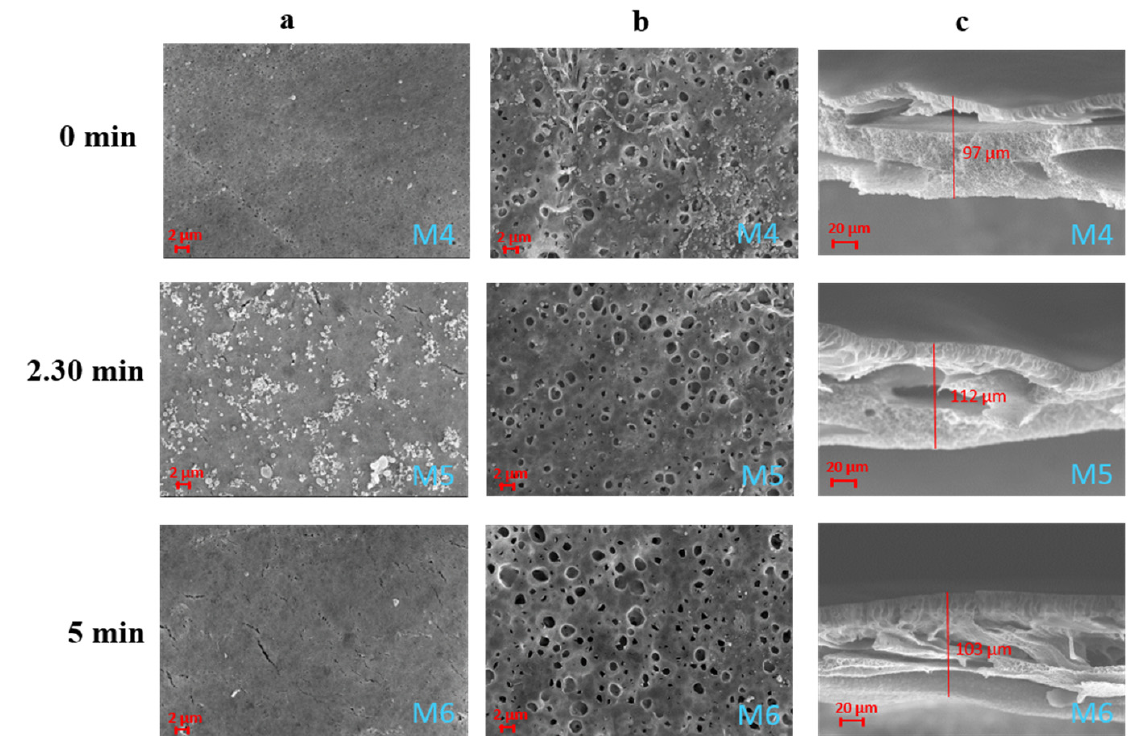
Figure 3. SEM images illustrating the effect of the exposure time to humidity on PVDF-HFP/PolarClean membranes M4–M6: ( a ) top surfaces; ( b ) bottom surfaces; ( c ) cross-sections.